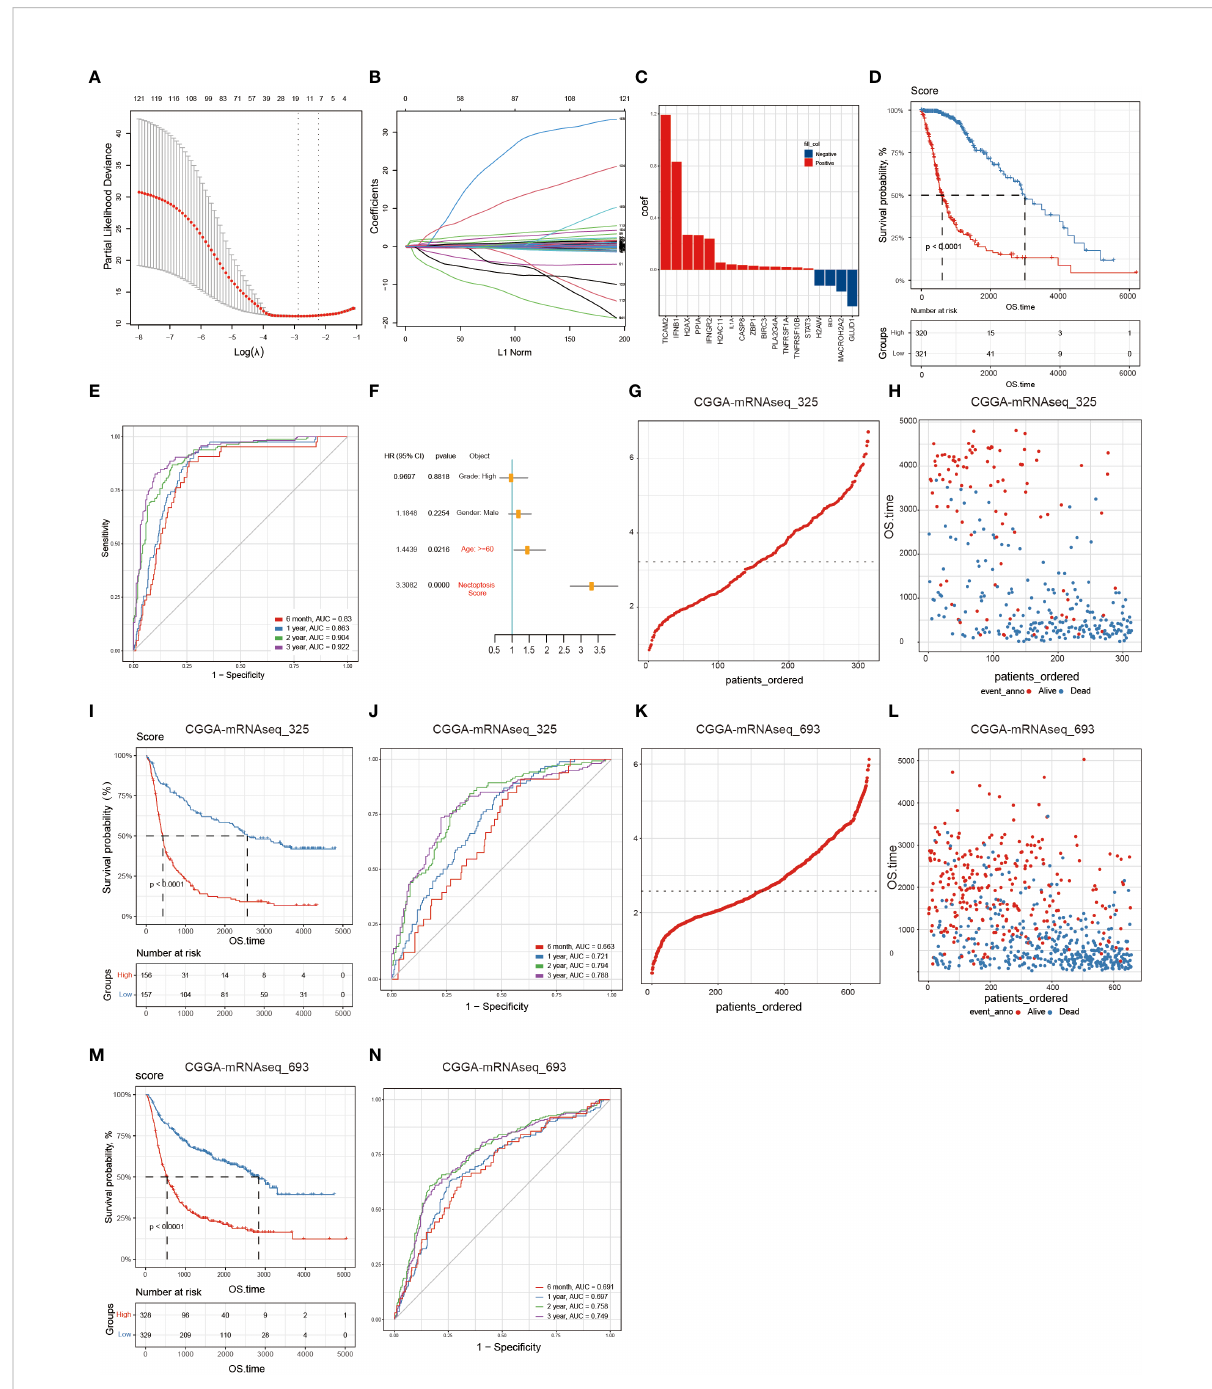
FIGURE 3 Building and validating the NRS. A total of 126 NRGs were selected via the univariate Cox regression and Lasso regression and signi fi cantly correlated with prognosis. (A) The most optimal parameter selected in Lasso regression by using the 10-fold cross-validation. Red dots indicate the likelihood of deviance values, gray lines represent the standard error (SE), and vertical dot lines correspond to optimal values by minimum criteria, and 1-SE, respectively. (B) The Lasso coef fi cient pro fi le of 126 NRGs, with each curve representing a gene. (C) A total of 18 NRGs were incorporated for the NRS construction. (D) The survival analysis of the NRS in the TCGA training set. (E) Veri fi cation of the NRS predictive performance using the Time-ROC analysis. (F) Univariate Cox regression analysis illustrates that signature and age were the independent prognostic factor for glioma patients. (G, H) The distribution of risk scores of glioma patients in CGGA-mRNA_325 and CGGA-mRNA_693 datasets, respectively. (I, J) Numbers of alive and dead patients with different risk scores in CGGA-mRNA_325 and CGGA-mRNA_693 datasets, respectively. (K, L) Survival analysis. (M, N) Time-ROC